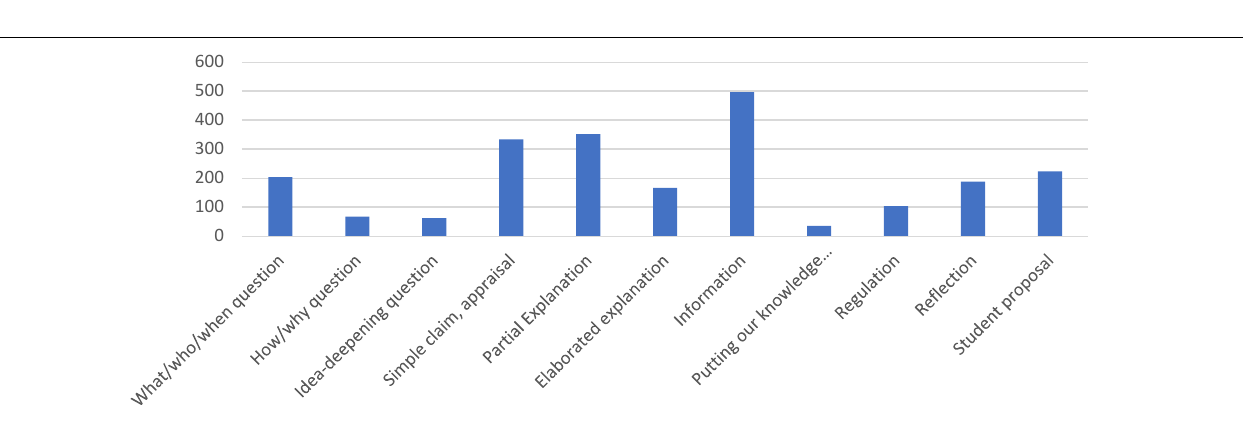
Frontiers in Education |